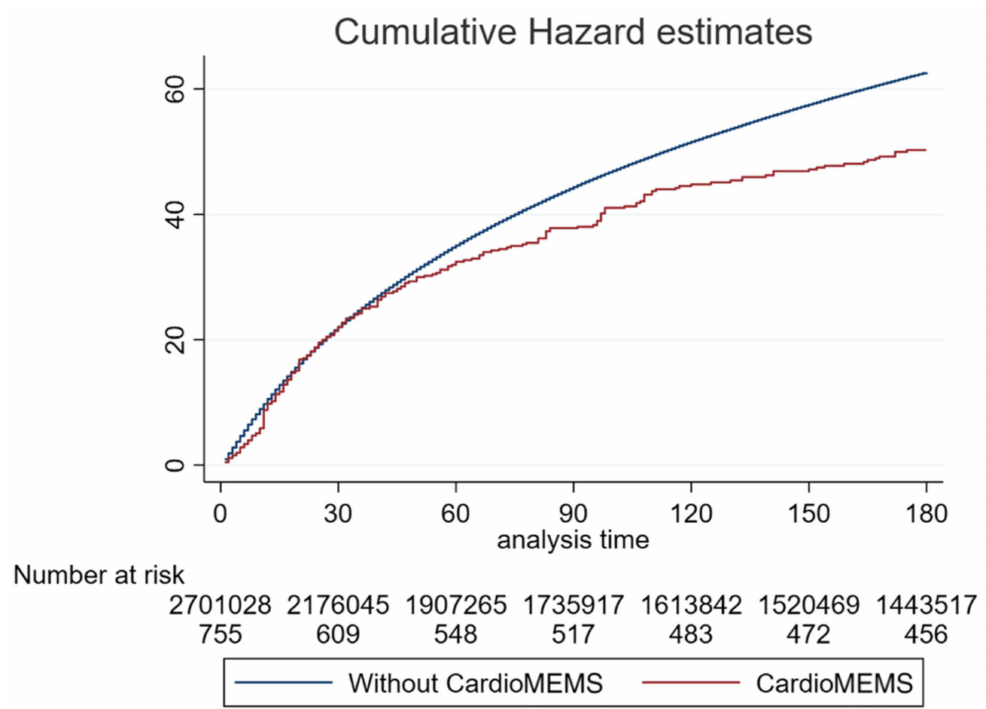
Figure 4. Cumulative incidence of heart failure readmissions during 180 days after discharge, stratified ac-cording to treatment (without or with CardioMEMS). Reprinted from ESC Heart Failure Volume 9, Issue 4, Kishino et al., Effect of pulmonary artery pressure-guided therapy on heart failure read-mission in a nationally representative cohort, pages 2511–2517, Copyright 2022, with permission from Elsevier